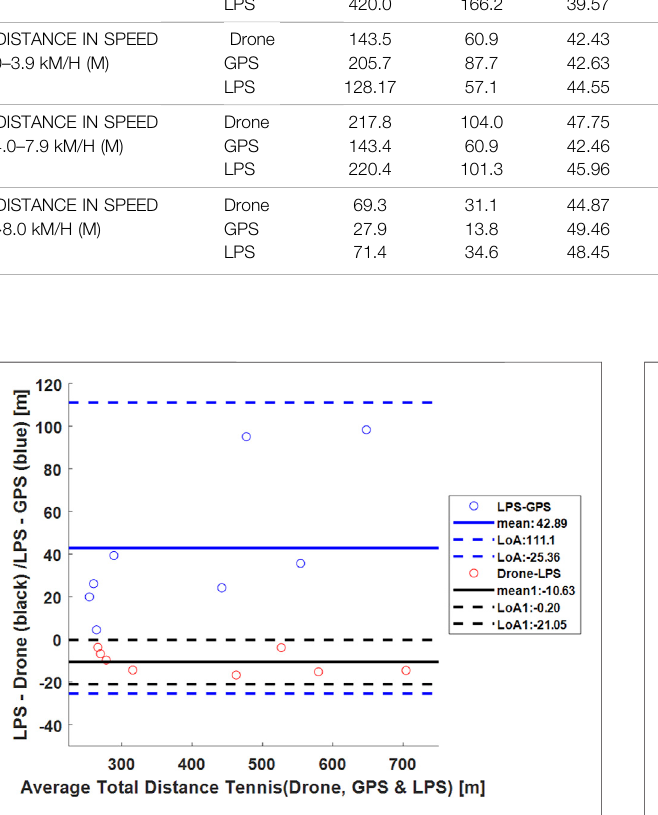
TOTAL DISTANCE (M)